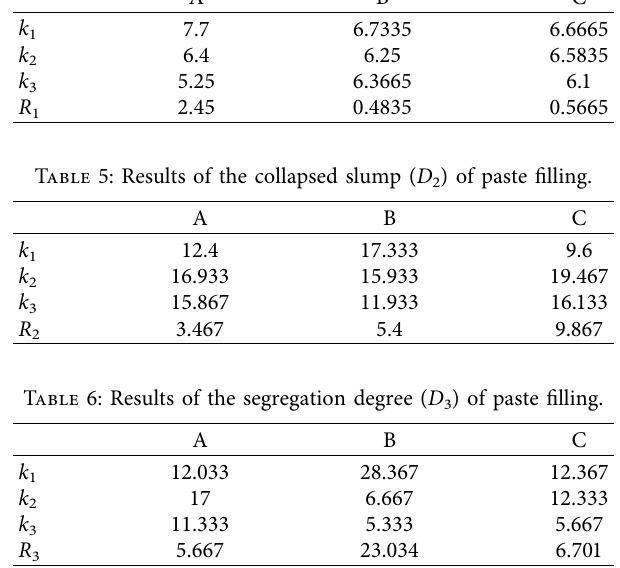
Table 7: Results of the bleeding ratio ( D